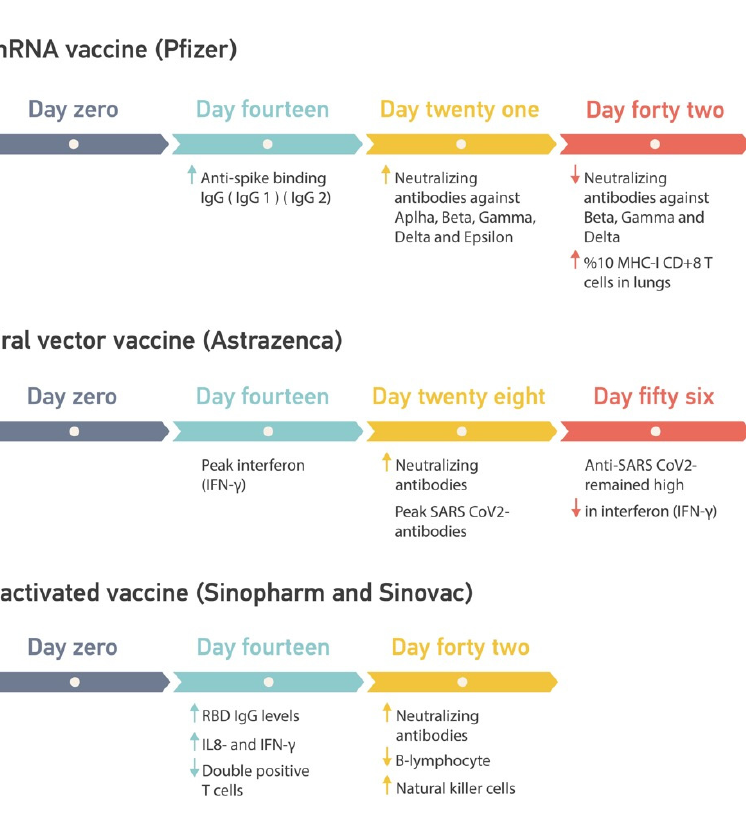
Figure 6. A time-course graph for immunological response in the different vaccination procedures.